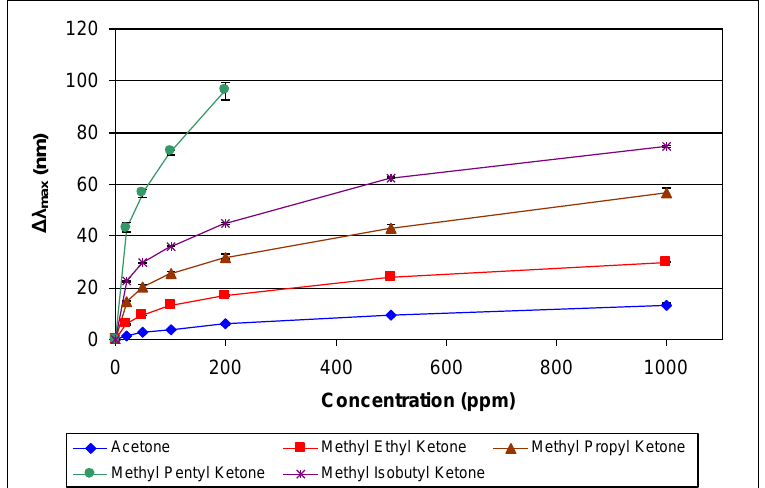
Figure 8. Response of sensor to ketones at various concentrations.